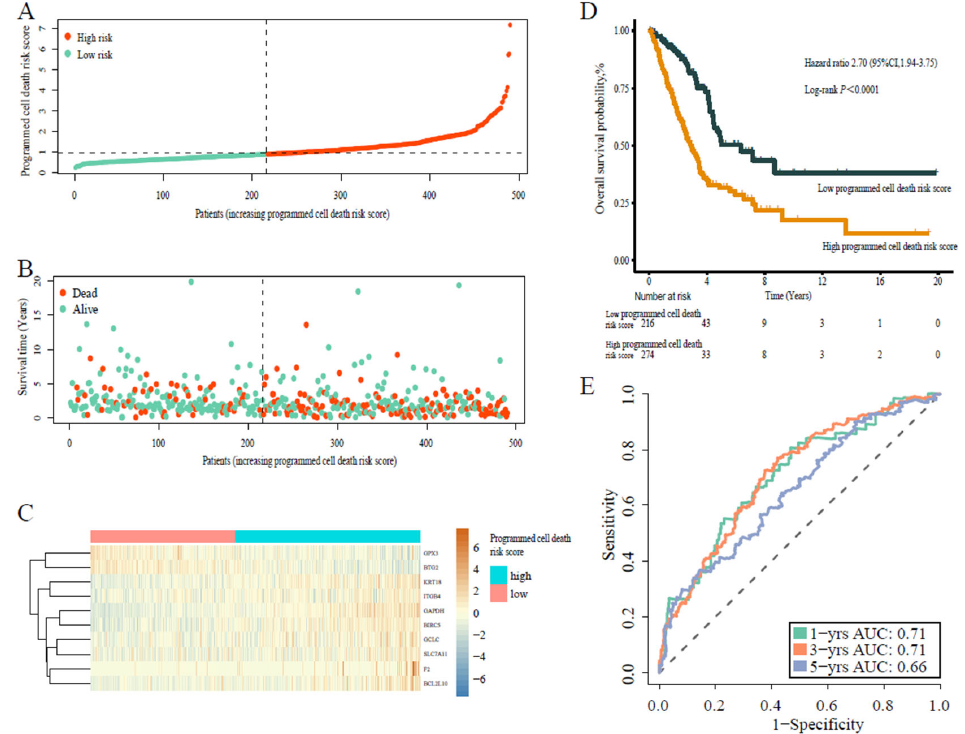
Figure 2. Prognostic analysis of programmed cell death risk score formula in the training cohort. ( A ) Distribution of the programmed cell death risk scores in the training cohort. ( B ) Patterns of the survival time and survival status of the patients based on programmed cell death risk scores. ( C ) Heatmaps of the ten prognostic genes for each patient of the training cohort. ( D ) Kaplan–Meier survival curve of the patients based on programmed cell death risk scores. ( E ) Time-related ROC analysis showing the prognostic performance of the programmed cell death risk score formula in the training cohort.